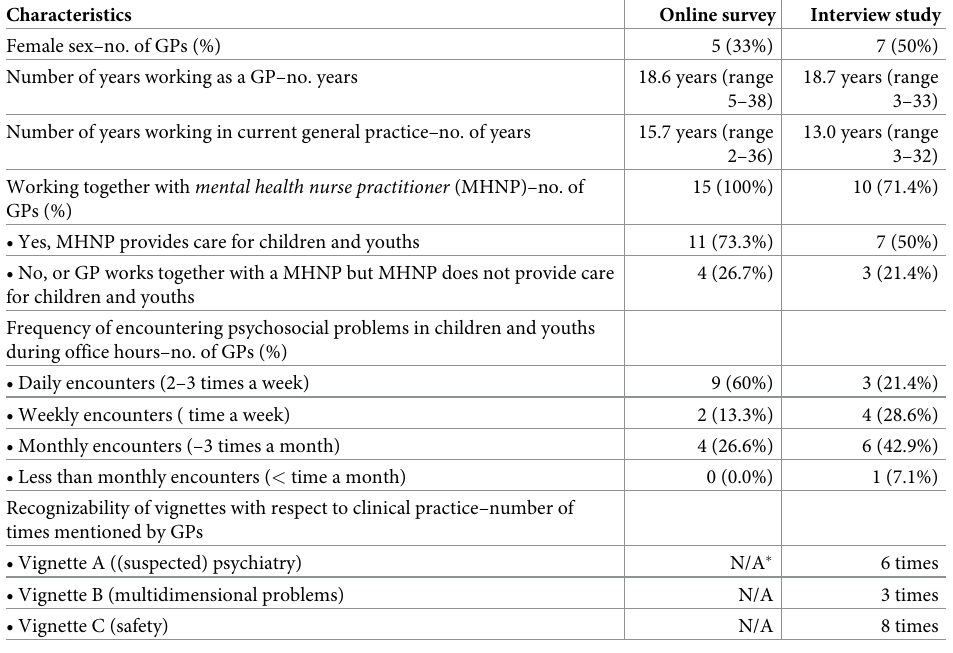
Table 1. Characteristics of GPs–online survey (n = 15) and interviews (n = 14), N = 29.